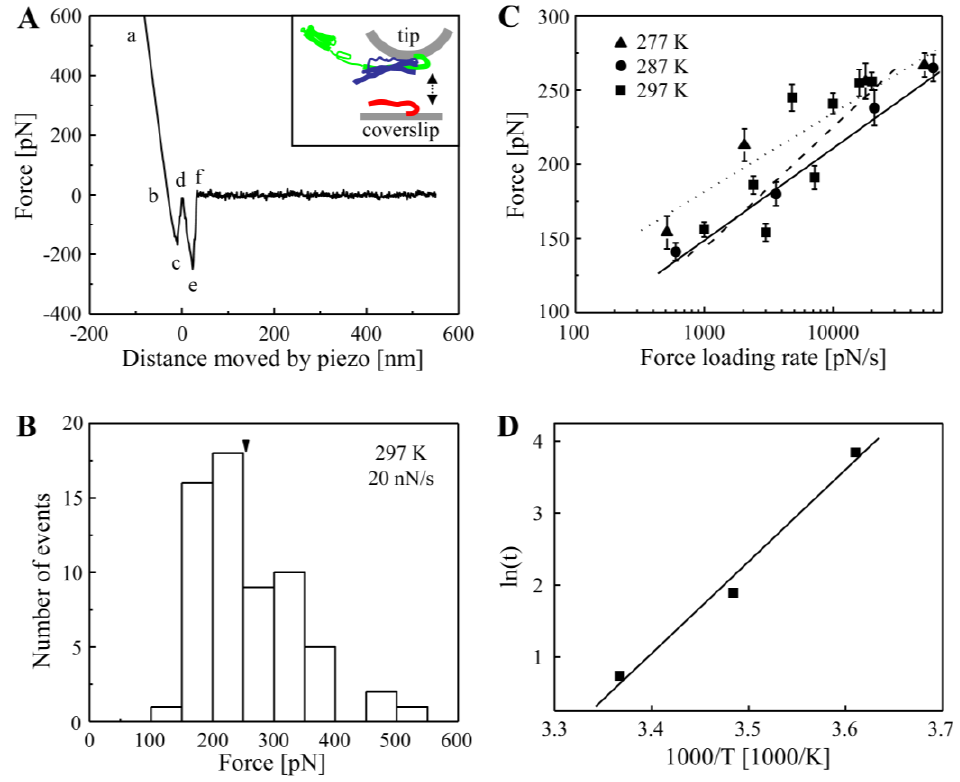
FIGURE 3. DFS approach for obtaining the disassembly energy of the ternary SNARE complex. (A) The inset (top right corner) represents a schematic of the experimental approach. The recombinant cytoplasmic domain of Sb2 (red) is attached at its C-terminus to the nickel-coated coverslip, allowing Sb2 interaction with the preformed binary complex containing SNAP25B (blue) bound to the cytoplasmic domain of Sx1A (green), and the latter being attached to the nickel-coated cantilever tip. These proteins are brought into contact by means of the piezoelectric element and then taken apart (double arrow). The graph shows the retraction part of a typical force-distance curve using an Sx1A + SNAP25B functionalized tip and an Sb2 functionalized coverslip. In the segments “ ab ” and “ bc ”, the coverslip and the cantilever tip are still in contact. The Sb2-Sx1A-SNAP25B intermolecular “bond” starts to be extended at point “ d ”, which represents the point of zero separation distance between the tip and coverslip. The increasing extension as the coverslip moves further away from the tip leads to increased application of the force on the intermolecular bond until it ruptures at point “ e ”. The segment “ ef ” is then the measure of the force (ordinate) necessary to remove the interaction between the proteins of the ternary SNARE complex. (B) The distribution of the forces at rupture for Sb2- Sx1A-SNAP25B single complex intermolecular interactions obtained at 297 K (24 o C) and the force loading rate of 20 nN/sec. The arrowhead represents the mean force at rupture. (C) The force values for dissociation of the SNARE proteins as a function of the force loading rate for three different temperatures of 297 K, 287 K (14 o C), and 277 K (4 o C) are shown as squares, circles, and triangles, respectively. Each point represents the mean  sem. The force necessary to take the ternary complex apart increases exponentially with the increase in the loading rate. The corresponding best fits, shown as straight solid, dashed, and dotted lines, when extrapolated to F = 0 are used to obtain spontaneous dissociation times. (D) The natural logarithm of the spontaneous dissociation time (t) for the ternary Sb2-Sx1A-SNAP25B complex plotted as a function of the inverse temperature. The straight line indicates the best fit to the data, where the slope and the intercept represent  H and  S, respectively. Modified from Liu et